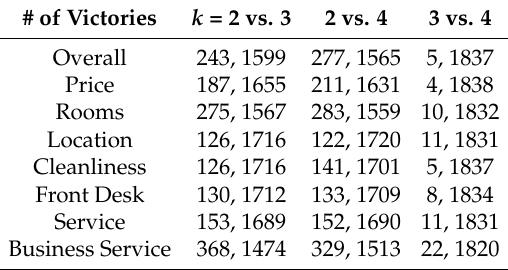
Table 13. Number of times k minimizes flooring error.